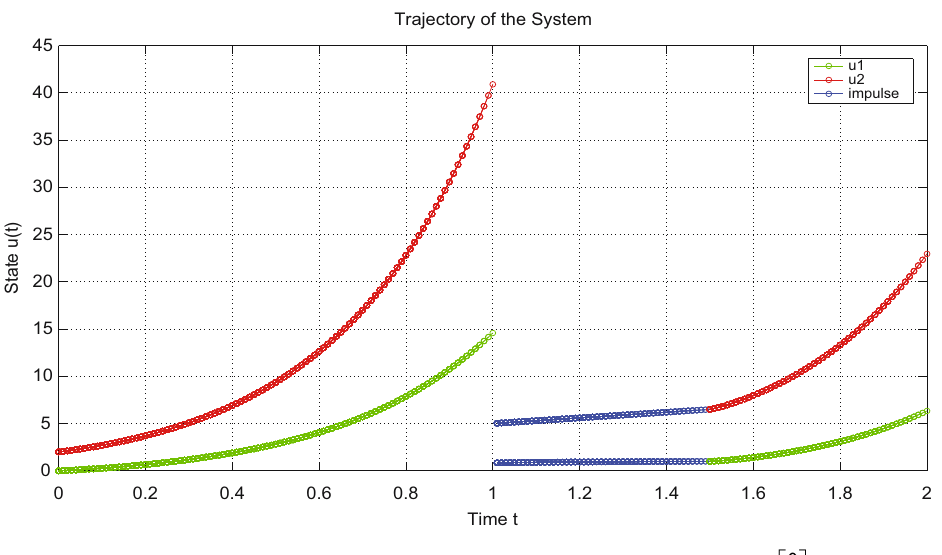
1 . The controllability Gramian matrix for system ( 6.2 ) is 0